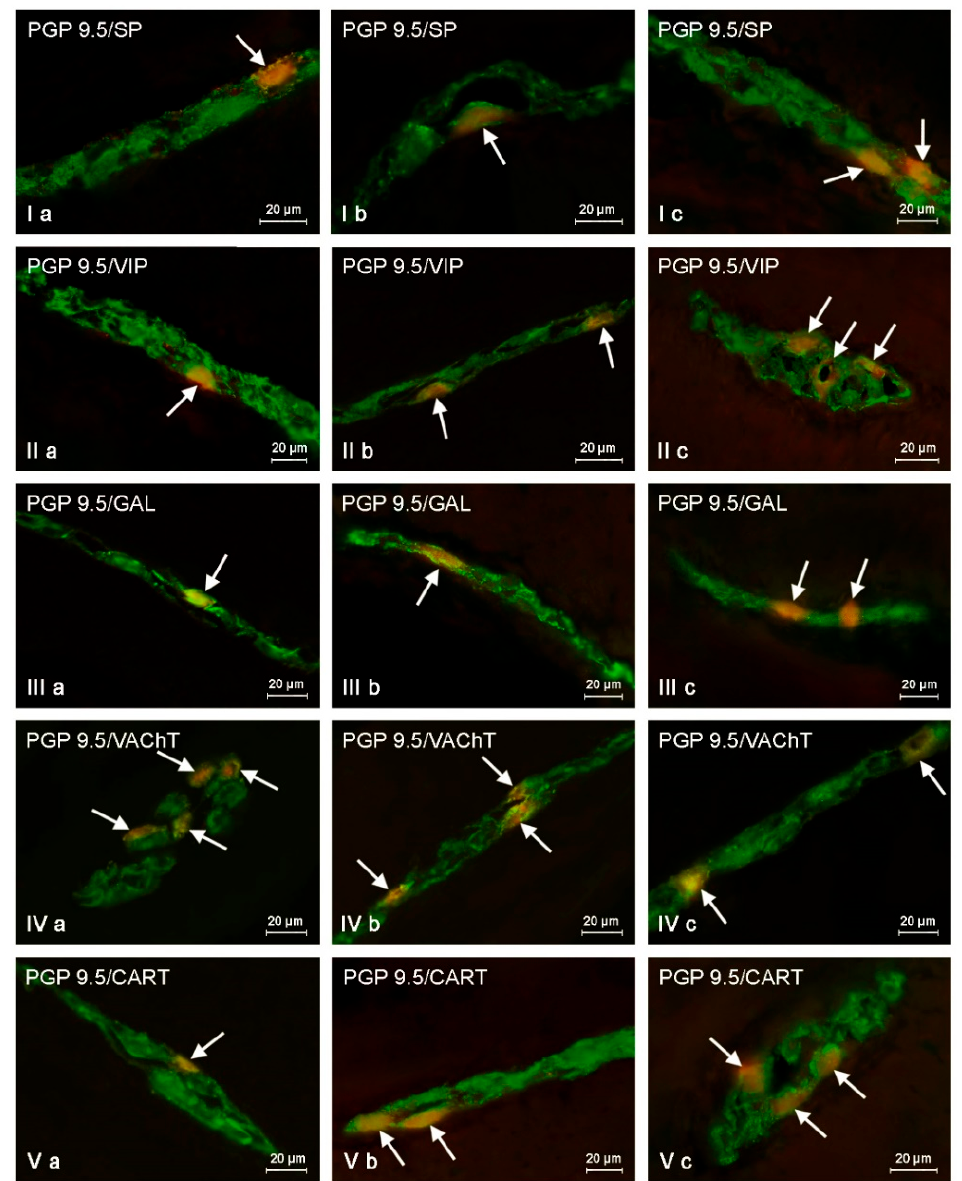
Figure 3. Myenteric plexus in control animals ( a ) and after BPA treatment in low ( b ) and high ( c ) doses, immunostained for protein gene product 9.5 (PGP 9.5, a pan-neuronal marker) and other neuronal factors including substance P (SP), vasoactive intestinal polypeptide (VIP), galanin (GAL), vesicular acetylcholine transporter (VAChT—used here as a marker of cholinergic neurons), and cocaine- and amphetamine-regulated transcript peptide (CART). Neurons showing co-localization of PGP 9.5 and other neuronal factors are indicated with arrows.